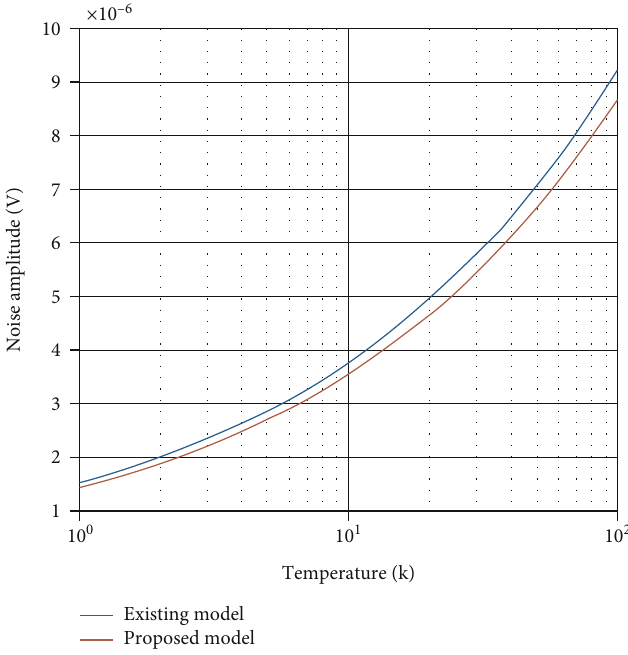
Figure 10: Temperature vs. noise amplitude plot for carbon